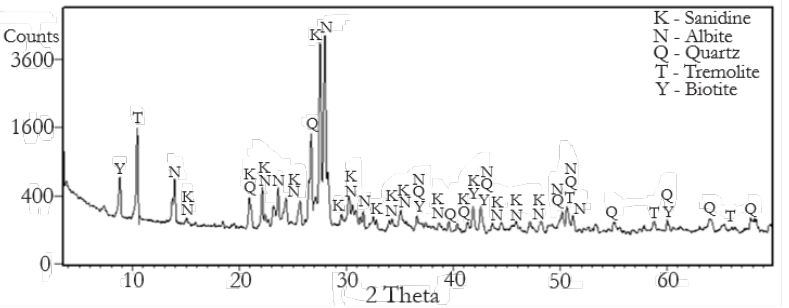
Figure 1. X-ray diffractogram of the reactive aggregate.